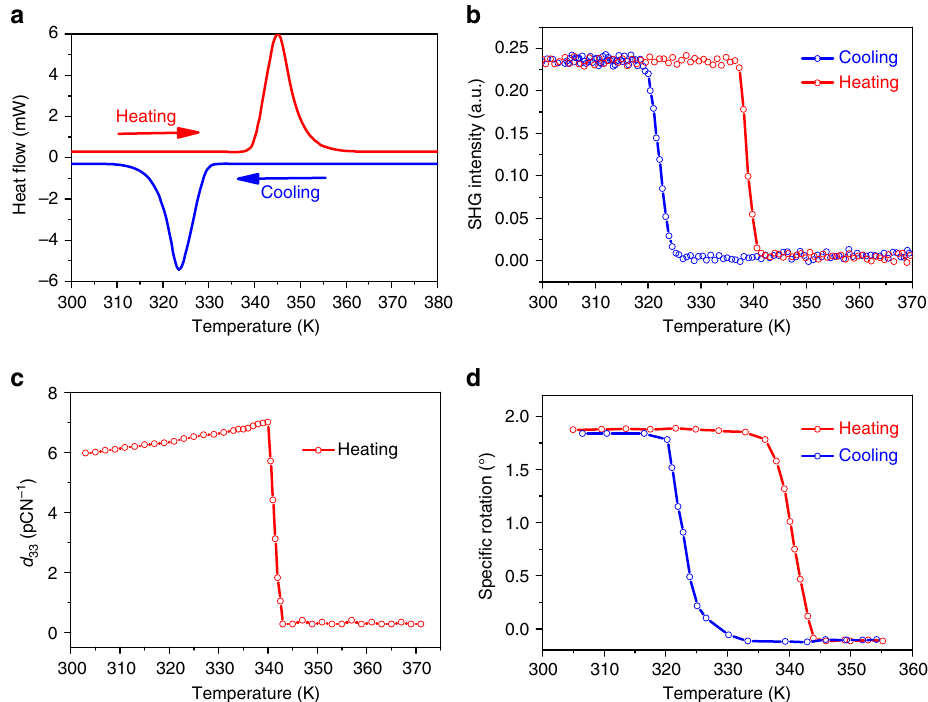
Figure 4 | Phase transition properties of 1. ( a ) The DSC (differential scan calorimetry) curve. ( b ) The temperature-dependence of the SHG signal. ( c ) The temperature-dependence of the piezoelectric coefficient d 33 . ( d ) Temperature-dependent specific rotation of a crystal through the optical